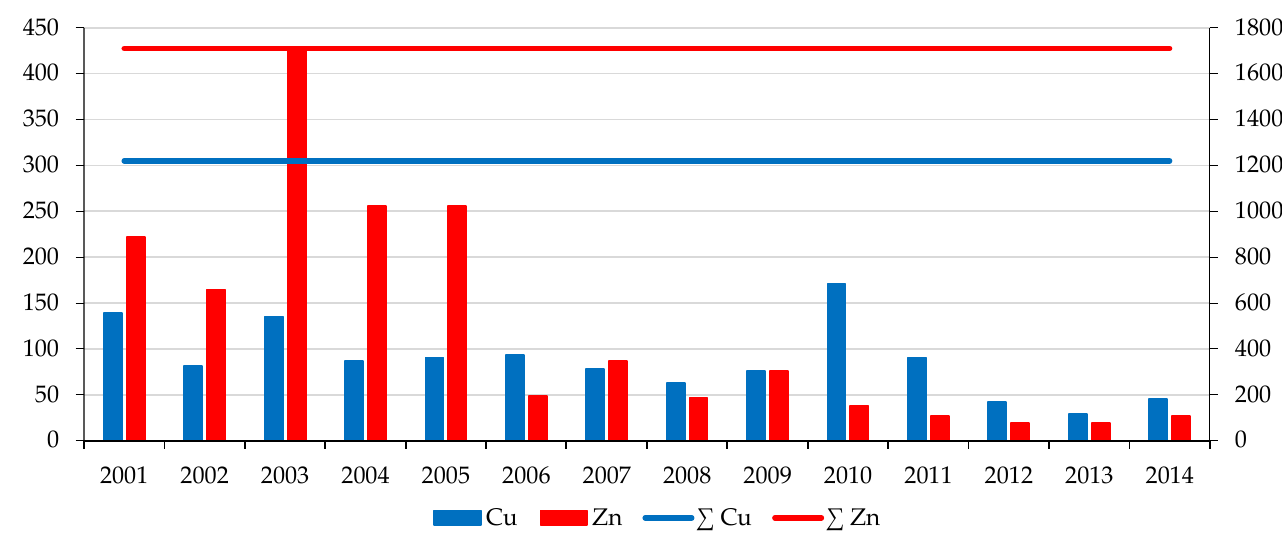
Figure 7. The inflow of heavy metals according to the data from cross-section Dobyn [54]. According to the results of the analysis of the Kazakhstan State Enterprise “Kazhy- dromet” materials, for the border cross-section of Dobyn for 2013, an increased level of inflow was recorded during the spring flood—Cu (9.11 t); Zn (5.93 t); Pb (1.94 t); Cd (0.07 t)—which remained in the summer season Cu (7.61 t); Zn (4.81 t); Pb (1.12 t); Cd (0.09 t) (Figure 8).